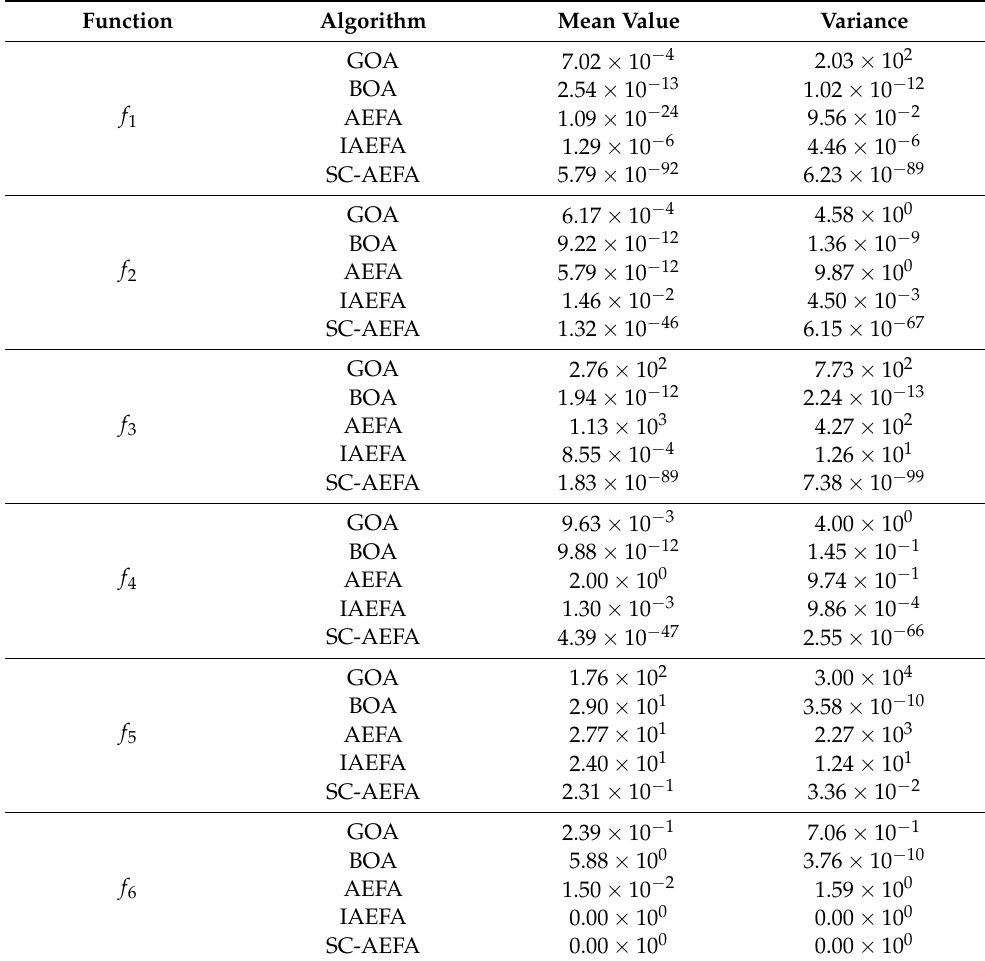
Table 2. A comparison of the optimization results of different